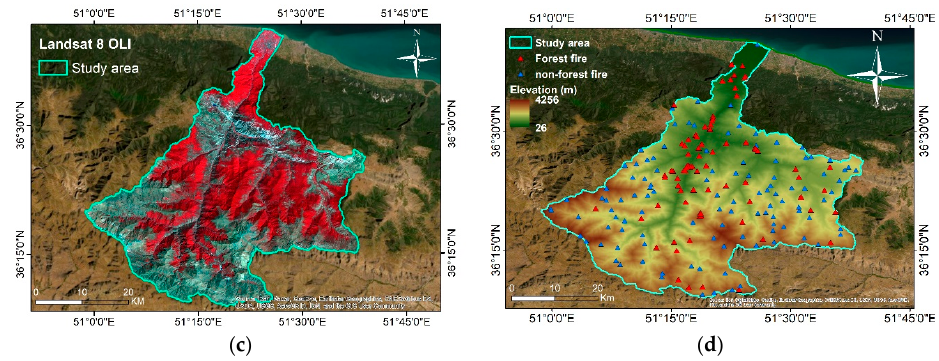
Figure 1. The study area describing: ( a ) map of Iran; ( b ) location of study area; ( c ) Landsat 8 satellite imagery of study area (bands 5, 4, 3); ( d ) The Chaloos catchment including digital elevation model (DEM), forest fire and non-forest fire inventories.